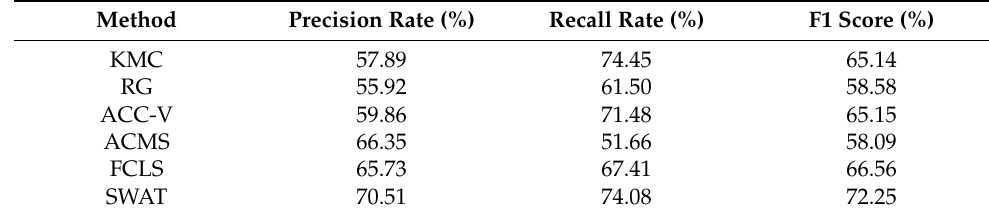
Figure 6. Results of the different segmentation methods on the DIARETDB1 fundus images dataset. Table 2. Statistical analysis of different methods on DIARETDB0